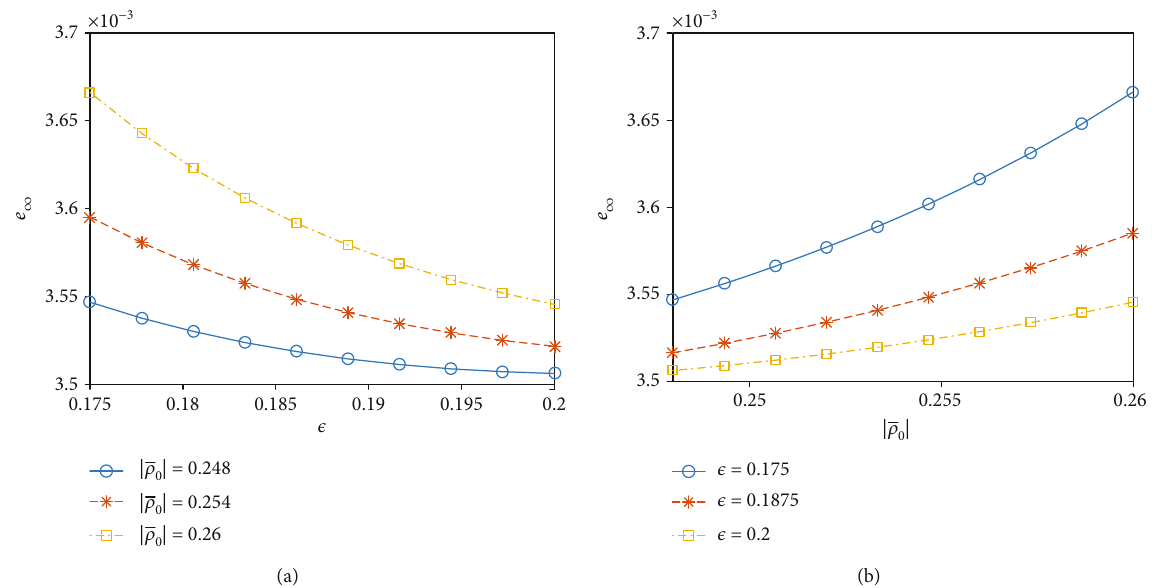
Figure 8: Viscoelastic-creep parametric study under step pressure. (a) In fl uence of the temperature, ϵ ( x -axis), parameter on e the ϵ parameter ranges between 0.175 and 0.200 with three di ff erent j (cid:1) ρ j parameter ranges between 0.248 and 0.260 with three di ff erent ϵ values. All numerical experiments are based on step e ∞ ( y -axis) at the j (cid:1) ρ 0 (cid:1) pressure input ( Δ = 0 : 02 ). It should be noted that the ϵ parameter is inversely related to P 0